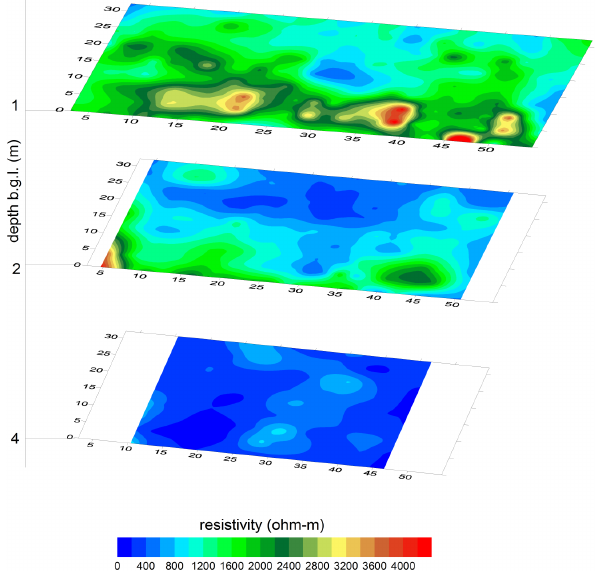
Fig. 9. Contour maps of resistivity obtained from the results derived from the 3-D data inversion related to the spring survey.